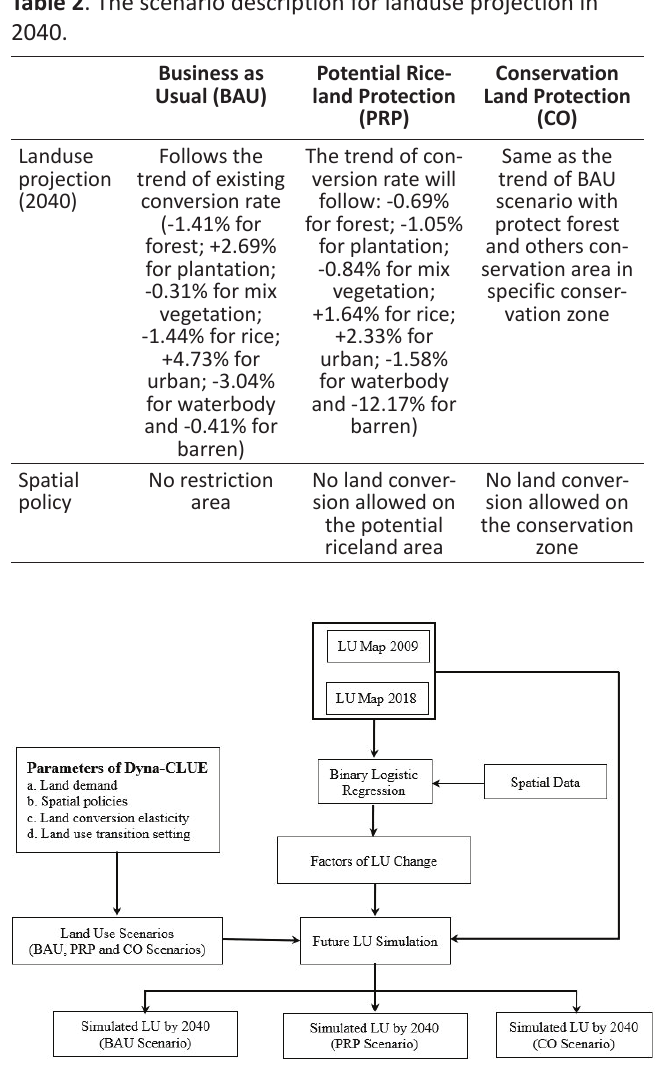
Figure 3. Method to simulate future landuse change.